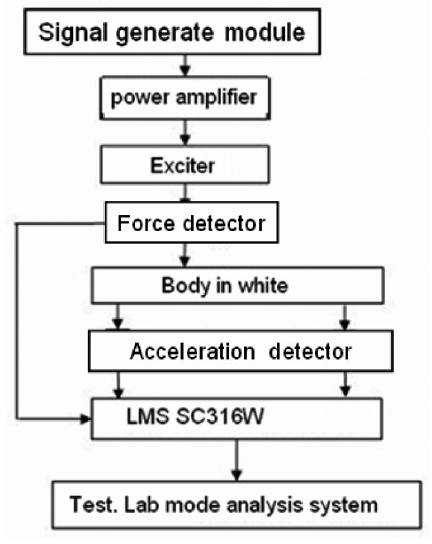
Fig. 9. The sketch map of mode testing system for